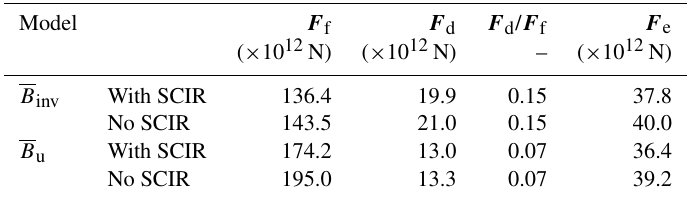
Table 2. Force budget components generated by Roosevelt Island in the reference and perturbed models. τ b is not computed here because horizontal velocities on Roosevelt Island are nearly